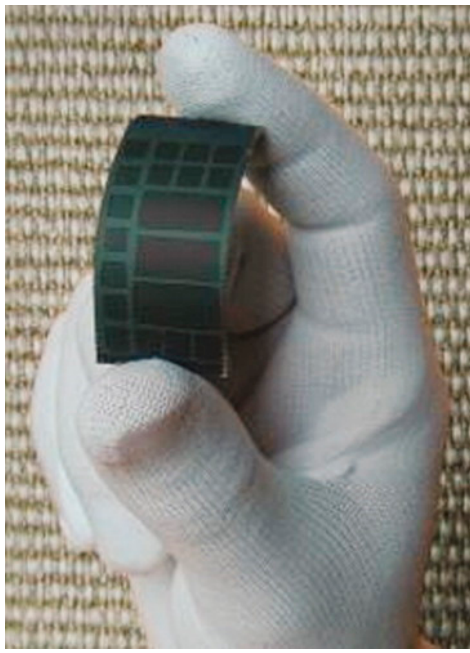
Figure 9. Photograph of the flexible copper indium gallium selenide thin film solar cell on glass fabric developed by Knittel et al. Reprinted from [123] with permission from Wiley.